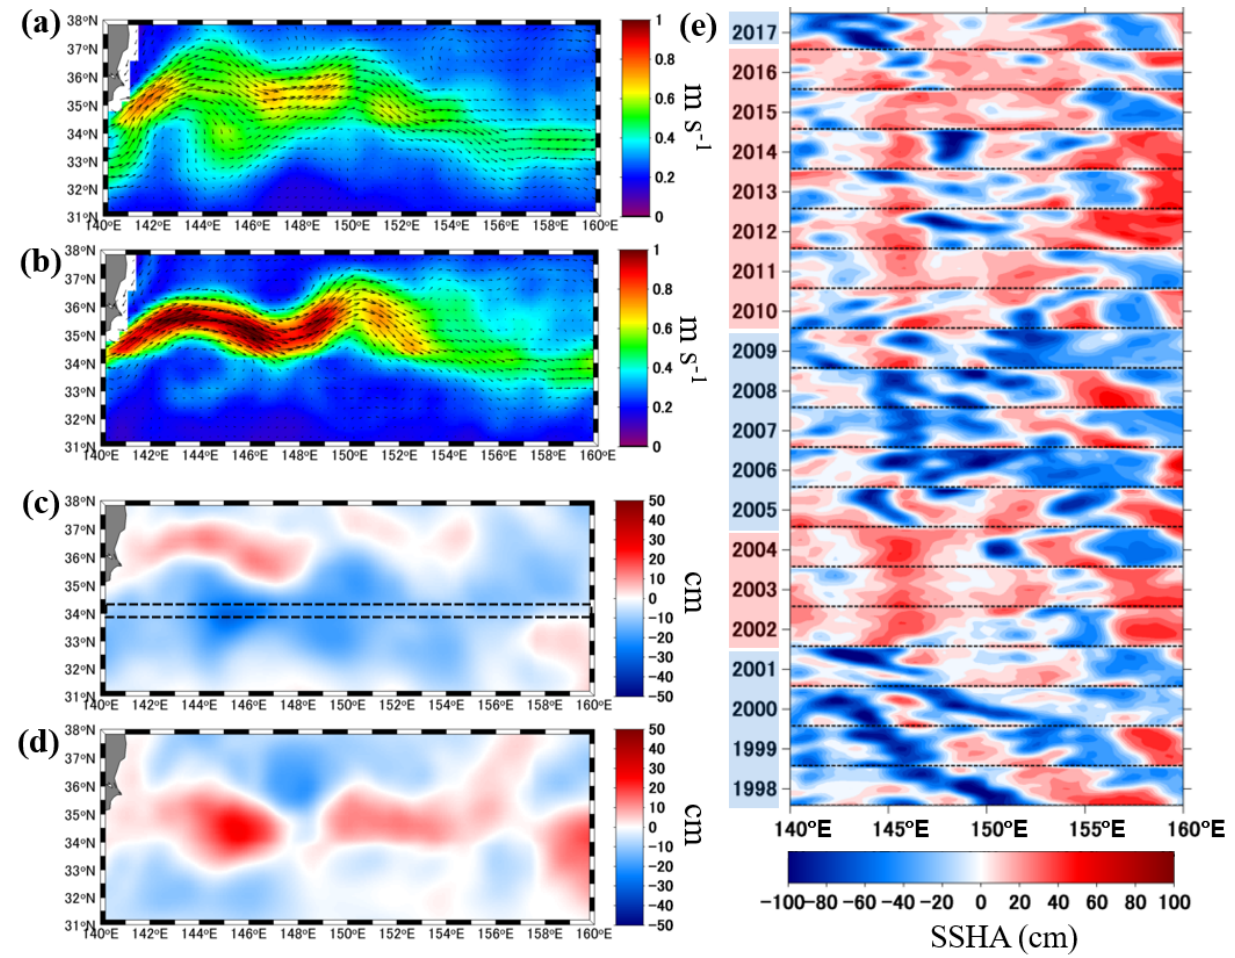
Figure 2. The winter (January–March) ocean surface currents in the study region based on Ocean Surface Current Analysis Real-Time data during the periods of unstable Kuroshio Extensions (KEs) ( a ) and periods of stable KEs ( b ). Panels ( c , d ) are the same as panels ( a , b ), except they show the sea surface height anomalies (SSHAs). Panel ( e ) shows the time series (1998–2017) of winter SSHAs averaged within the area indicated by the black dashed box in ( c ). The labeled years ( y -axis) in ( e ), highlighted by the blue and red colors, are the periods when the KE experienced unstable and stable conditions, respectively.